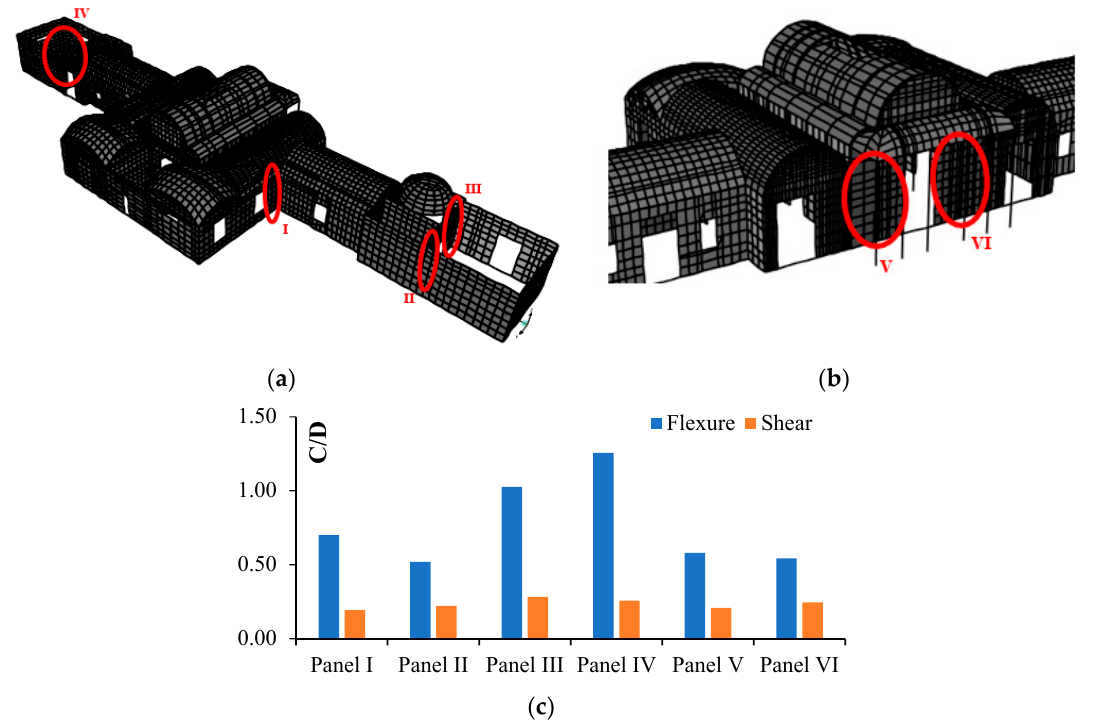
Figure 8. Most vulnerable panels in Y ( a ) and X ( b ) direction; ( c ) C/D ratio for the most vulnerable panels.